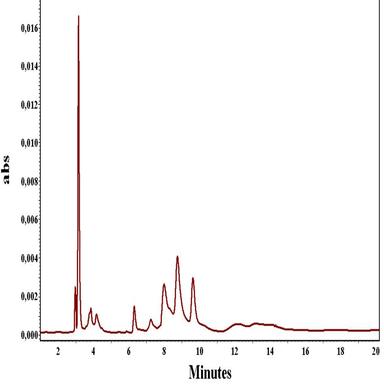
Chromatogram obtained from the analysis of pag. 50 of the volume 410.